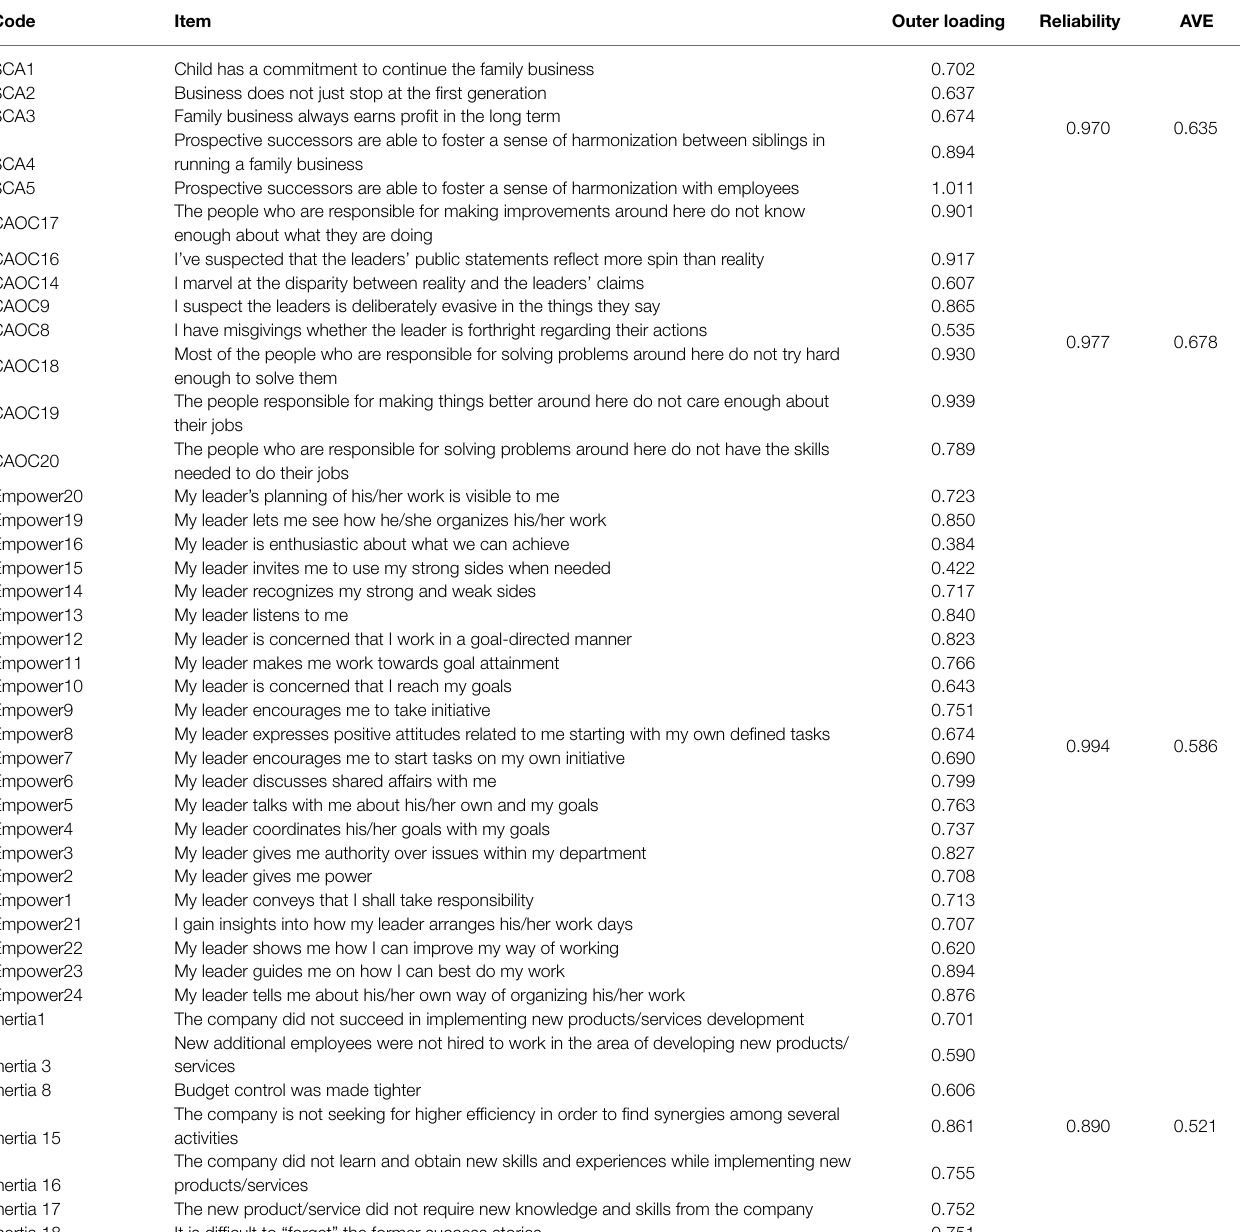
TABLE 1 | Validity and reliability